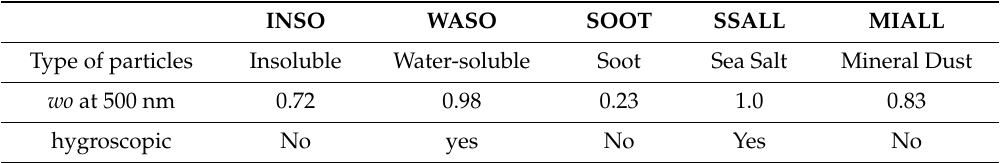
Table 1. List of the single scattering albedo ( wo ) and hygroscopic nature of the GADS aerosol components, as used by the MDSSFTD algorithm. INSO WASO